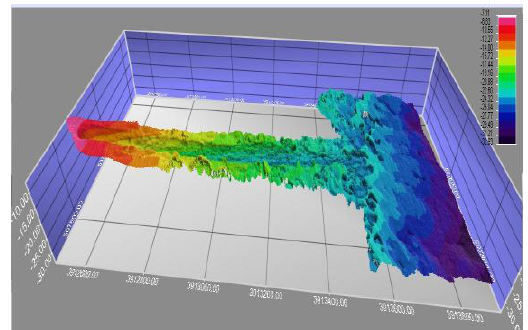
Figure 8: TRNC side 3D seafloor model .